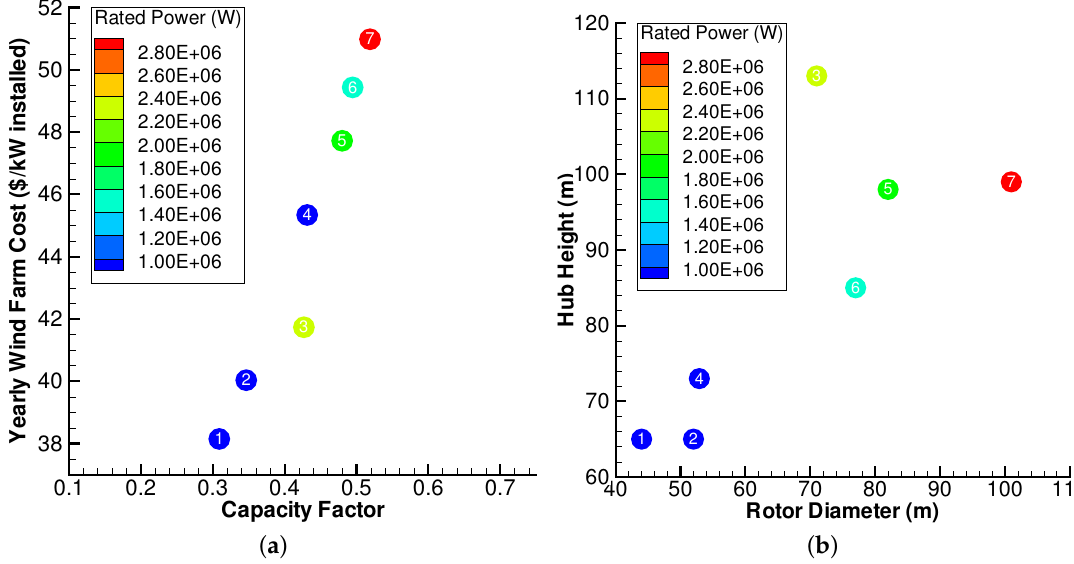
Figure 15. Tradeoffs offered by the best performing turbines of different rated powers for Case II: Class 2–3 winds. ( a ) Best tradeoffs between the capacity factor and average annual cost ($/kW installed); ( b ) rotor diameters and hub heights of the best tradeoff